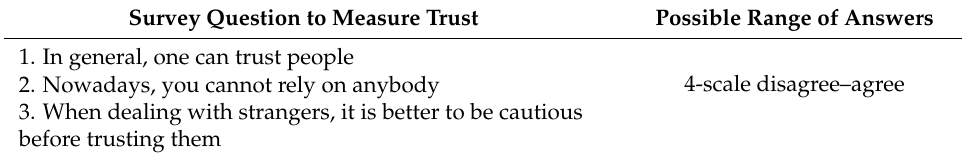
Table 6. Survey measures of trust by SOEP in